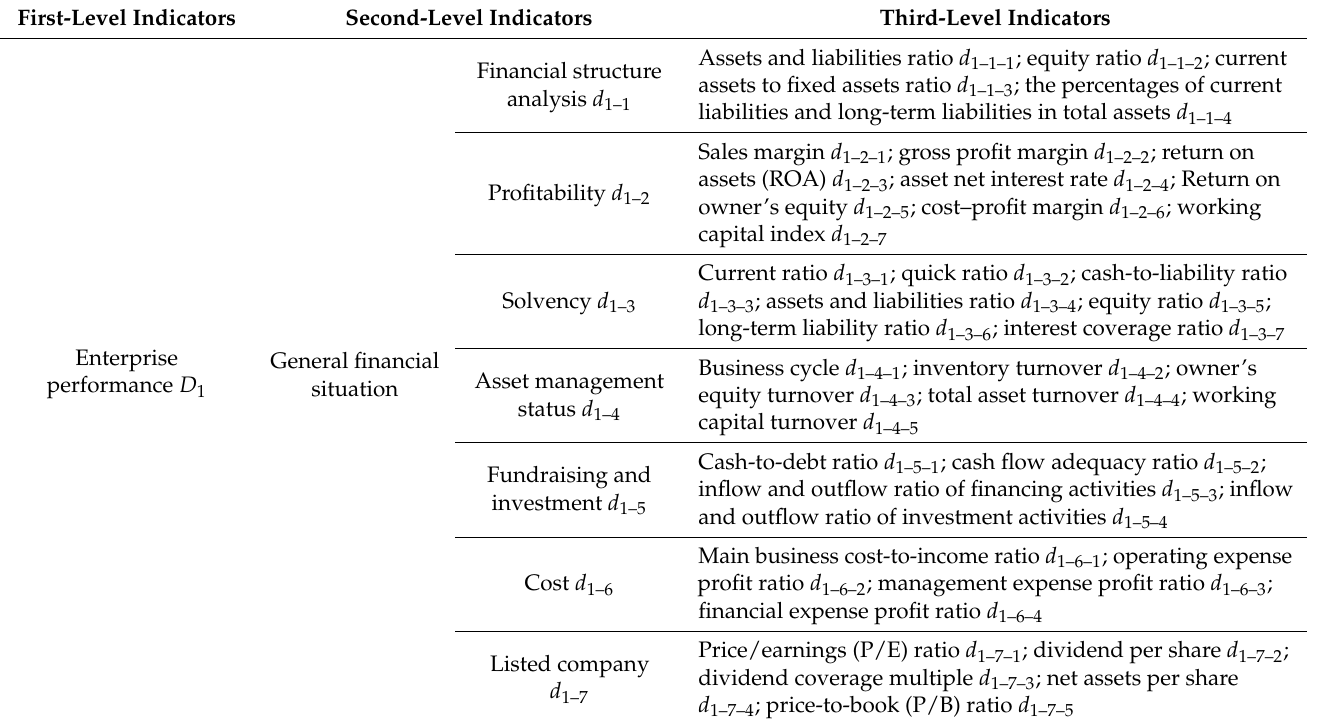
Table 2. Candidate indicators for enterprise